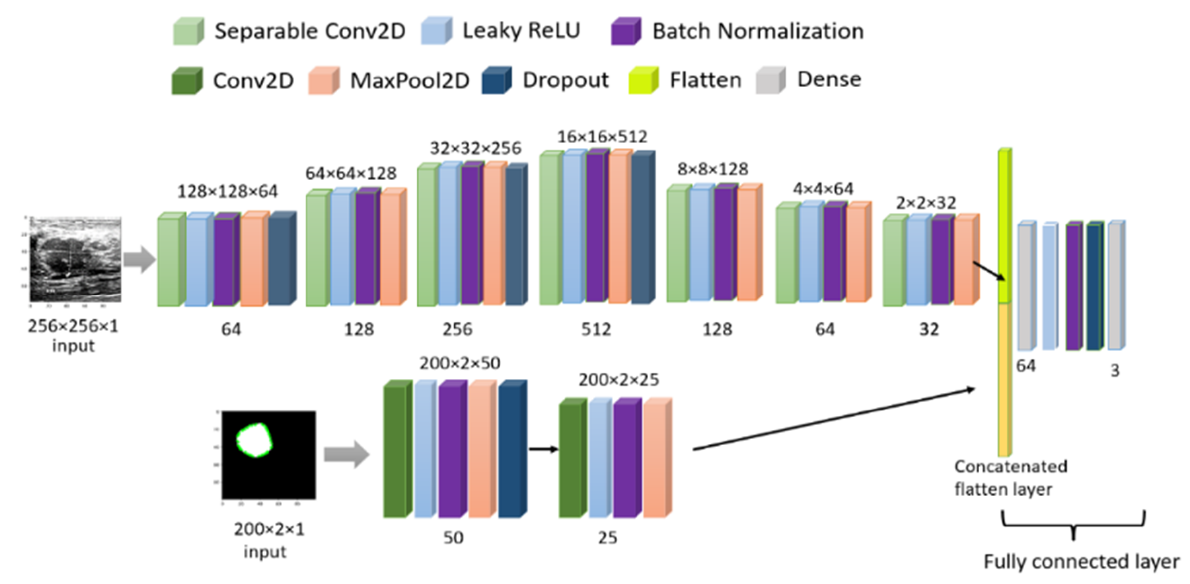
Figure 11. Model architecture for combined image training. Table 4. Parameter details of used Multi-headed model.